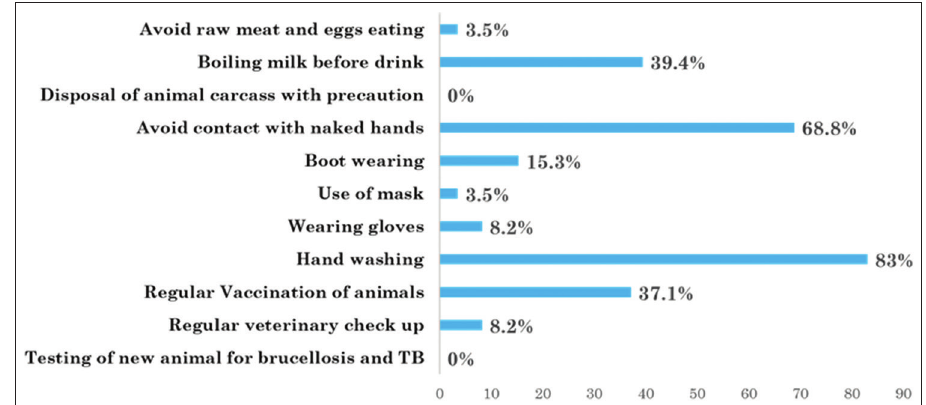
Figure-3: Preventive Table-1: Self-reported Z/D/S Burden of the past 5 years possibly linked to animal handling. Variables n=170 (%) Self-reported Z/D/S burden at HH level